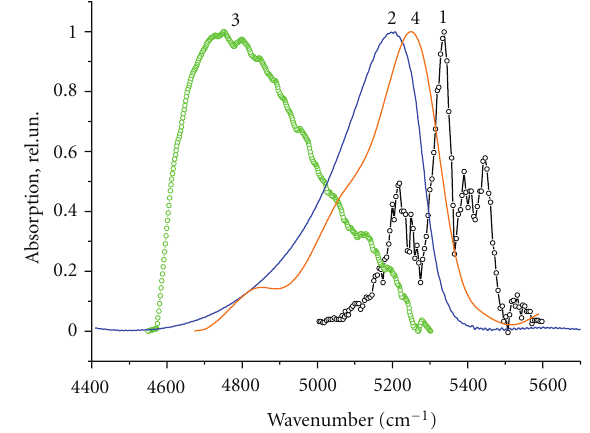
Figure 1: The absorption spectra in the range of 4500–5800cm − 1 of water monomer (1), bulk water (2), and water clusters in SiO 2 with pores diameter of 12nm (3) and 50nm (4).